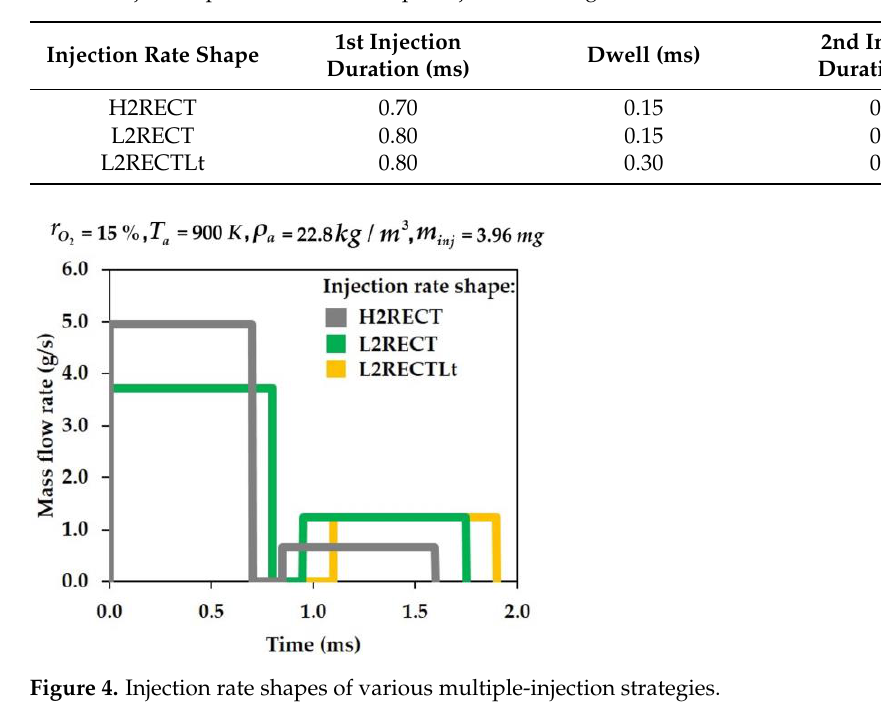
Figure 3. Comparison of simulation results of HRR and experimental data in different cases. Table 3. Injection parameters of multiple-injection strategies.